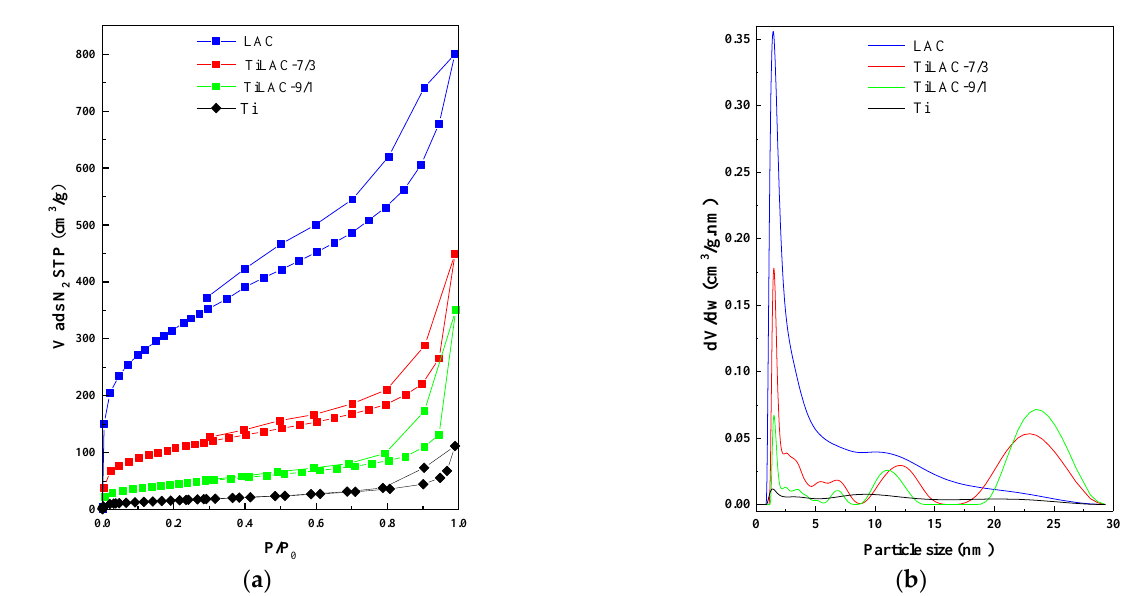
Figure 1. ( a ) Adsorption – desorption isotherms of N 2 at −196 °C and; ( b ) pore size distribution of the prepared luffa activated carbon and TiLAC composites.